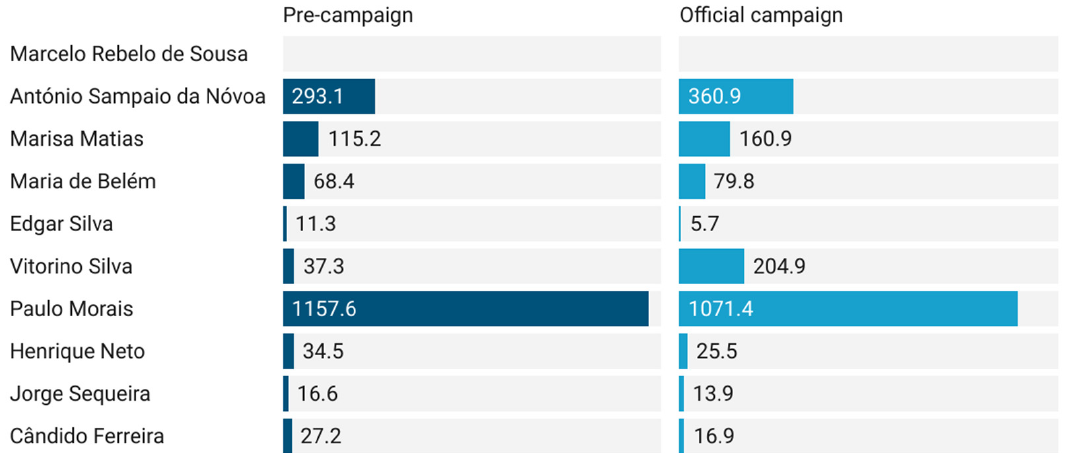
Figure A4. Online campaigning before and after the beginning of the official election campaign in